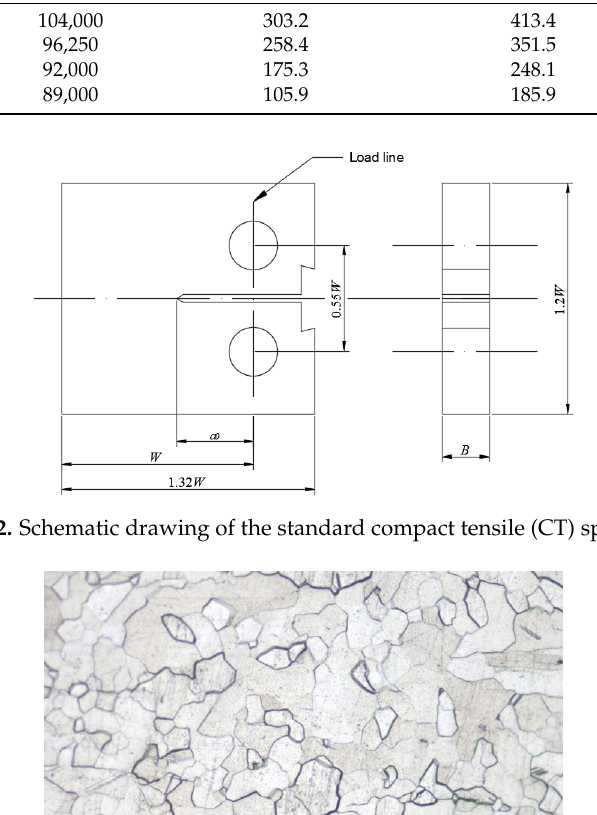
( b ) Figure 4. Schematic drawing of the loading waveforms: ( a ) triangular for the pure fatigue loading; ( b ) trapezoidal for the dwell fatigue loading. 3. Results and Discussion